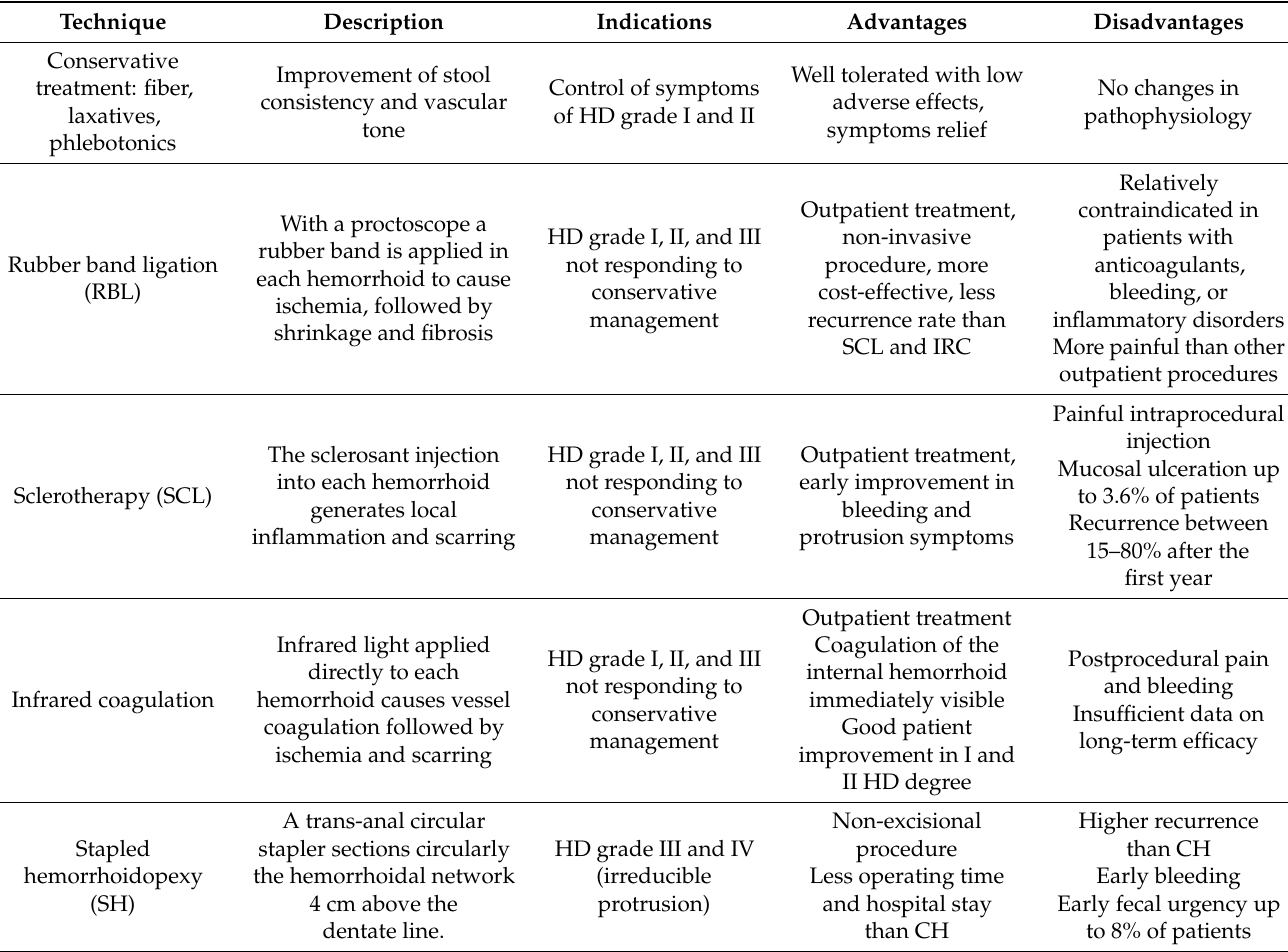
Table 3. Existing treatments for